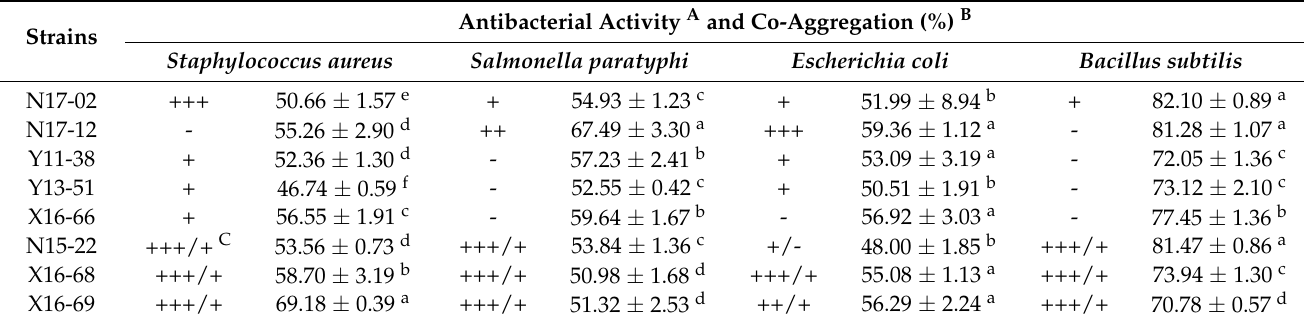
Table 5. Antibacterial activity and co-aggregation ability of probiotic strains against indicator strains. Antibacterial Activity A and Co-Aggregation (%) B Strains Staphylococcus aureus Salmonella